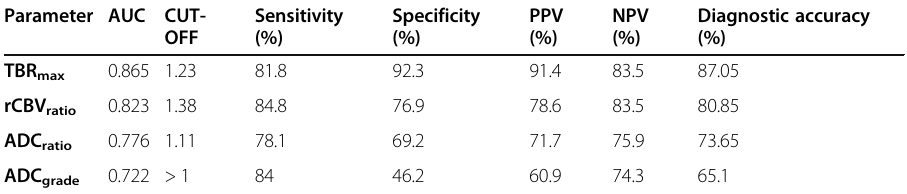
Table 2 Area under curve values with sensitivity, specificity, positive predictive values (PPV), negative predictive values (NPV), and diagnostic accuracy for important PET, perfusion, and diffusion